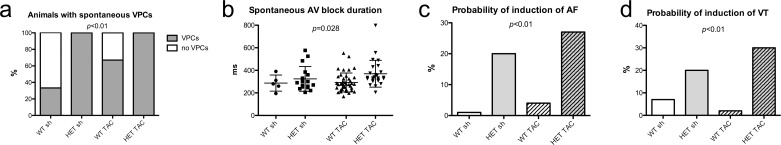
Spontaneous and inducible arrhythmias.a) During telemetric recordings only 33% of WT sh mice showed ventricular premature contractions (VPCs). After TAC this ratio increased to 67%. Spontaneous VPCs were present in all HET mice, both in the sham and TAC group. p calculated with Fisher´s exact test. b) Spontaneous AV blocks were present in all mice. However, HET TAC mice exhibited significantly longer pauses compared to WT TAC. * = p<0.05 with Tukey’s Multiple Comparison Test. c) The probability to induce atrial fibrillation during an electrophysiological study was highest in HET TAC. p calculated with Fisher´s exact test. d) Similarly, the probability to induce ventricular tachycardias was most pronounced in HET TAC. p calculated with Fisher´s exact test. for a) and b): WT sh: 1 male, 2 female, mean age 22.3 weeks; HET sh: 2 male, 1 female, mean age 19.8 weeks; WT TAC: 2 male, 1 female, mean age 20.0 weeks; HET TAC: 1 male, 2 female, mean age 19.5 weeks. for c) and d): WT sh: 4 male, 3 female, mean age 22.0 weeks; HET sh: 3 male, 4 female, mean age 21.6 weeks; WT TAC: 4 male, 3 female, mean age 19.4 weeks; HET TAC: 4 male, 3 female, mean age 19.6 weeks.